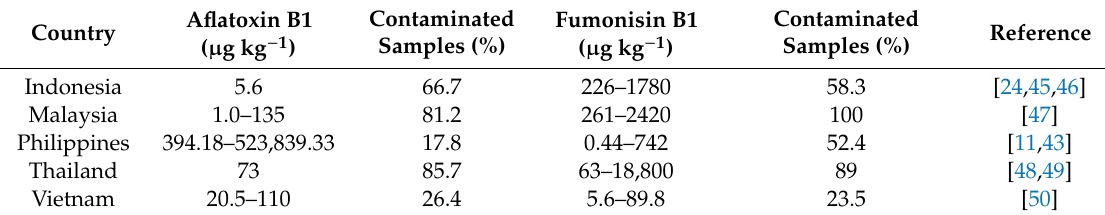
Table 4. Comparison of aflatoxin B1 and fumonisin B1 level in maize in selected Association of South East Asian Nations (ASEAN) countries with similar tropical climatic